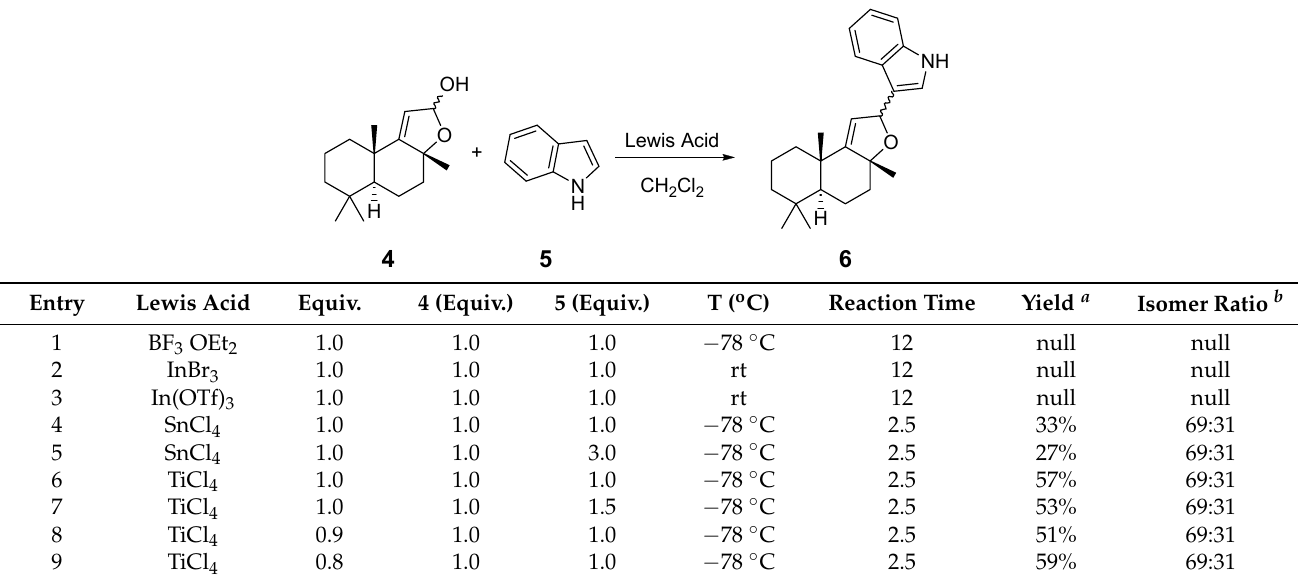
Table 1. Optimization of sclareolide–indole coupling reaction condition.